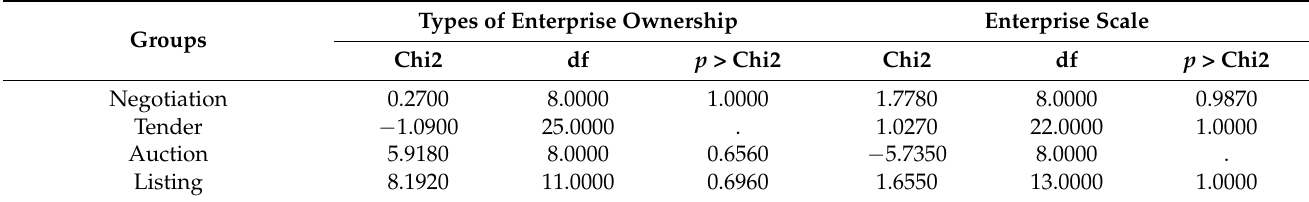
Table 14. IIA test results, 2013.